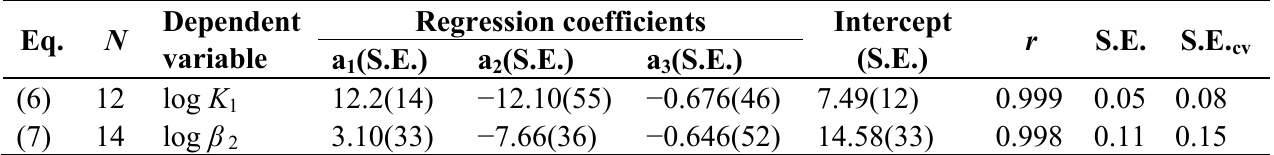
Table 2. Regression models for the estimation of the stability constants of mono - and bis -complexes.